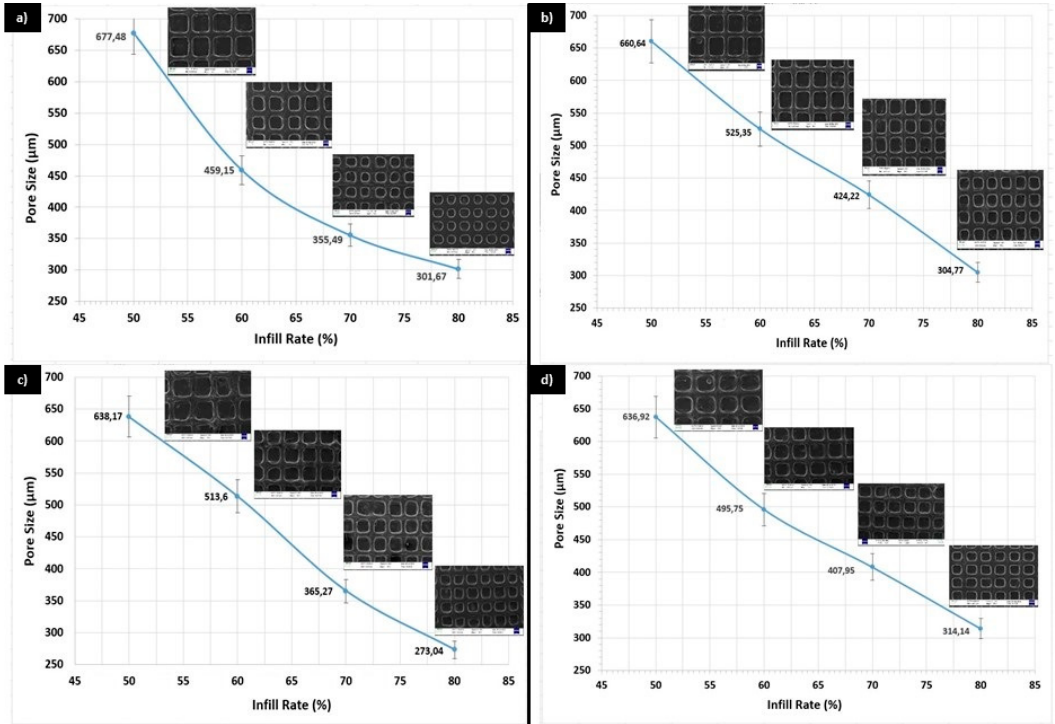
Figure 1. Mean pore size for ( a ) PCL/GEL, ( b ) PCL/GEL/BC, ( c ) PCL/GEL/BC/0.25%HA, ( d ) PCL/GEL/BC/0.50%HA solution at 50%, 60%, 70%, and 80% infill rate, respectively.